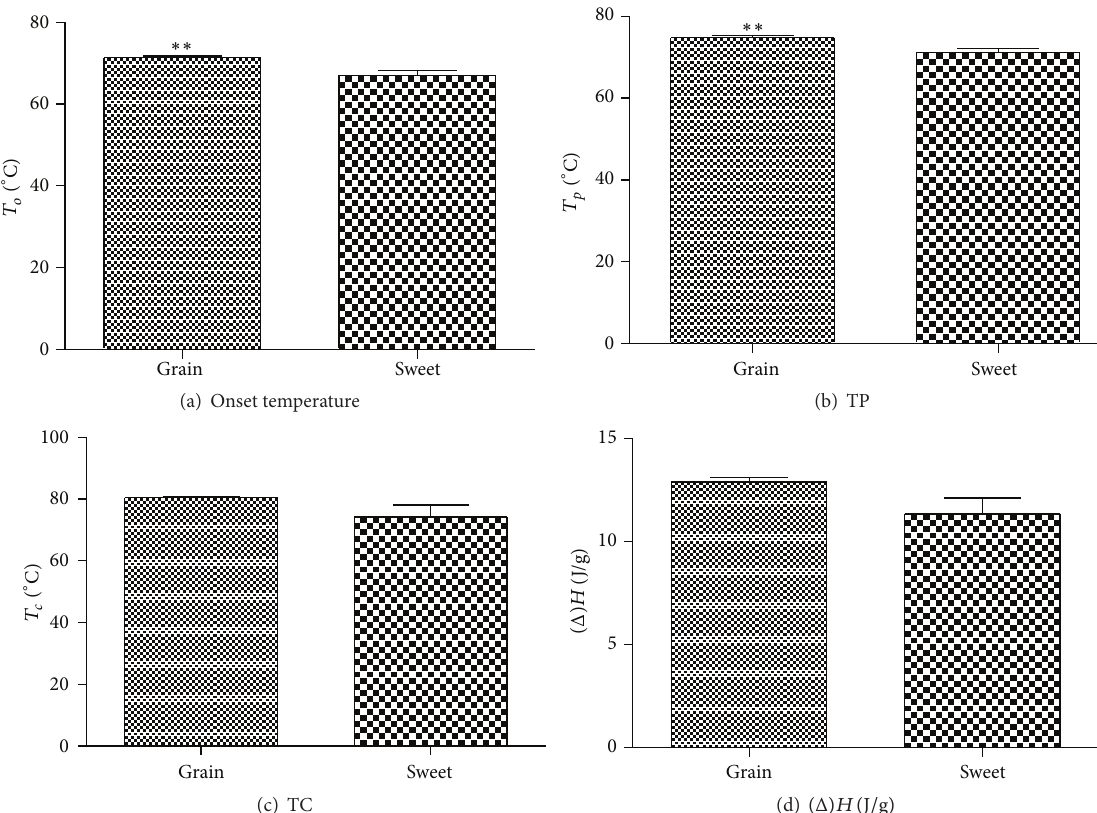
Figure 3: Comparison of starch thermal properties between sweet and grain sorghum varieties. (a)–(d) represent 𝑇 𝑜 , 𝑇 𝑝 , 𝑇 𝑐 , and Δ𝐻 , respectively. ∗∗ indicates that high significant difference ( 𝑝 < 0.001 ) was noticed.